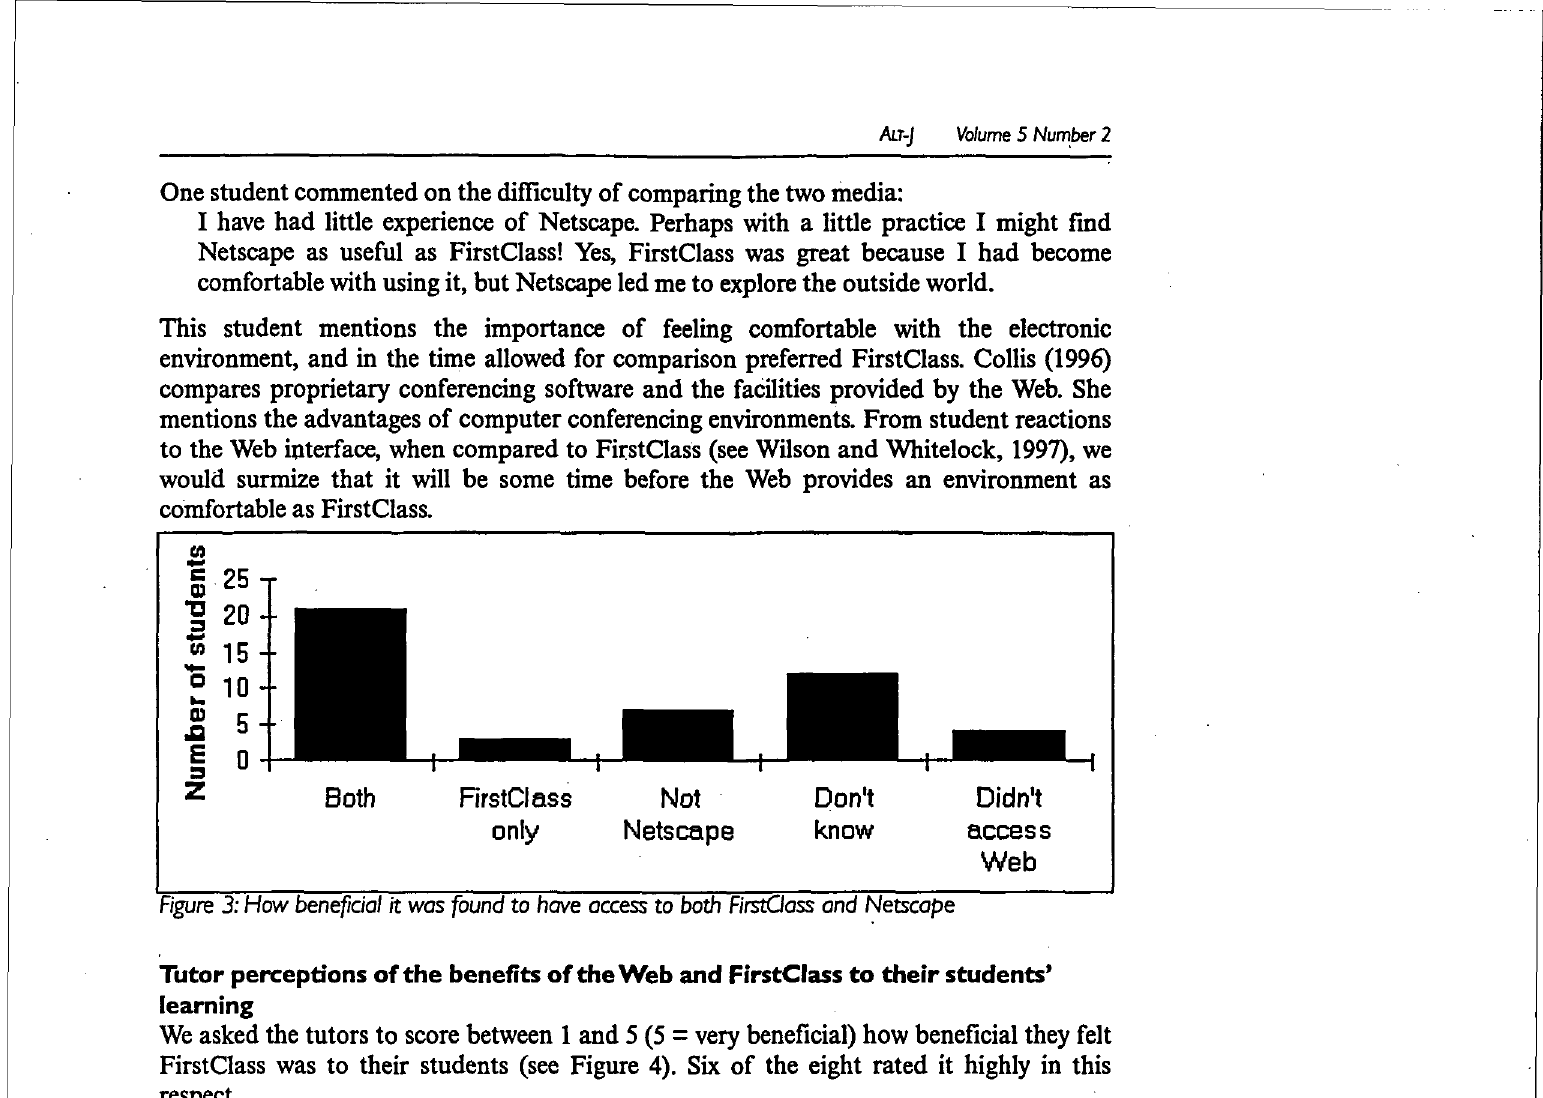
Figure 3: How beneficial it was found to hove access to both FirstQass and Netscape Tutor perceptions of the benefits of the Web and FirstClass to their students' learning